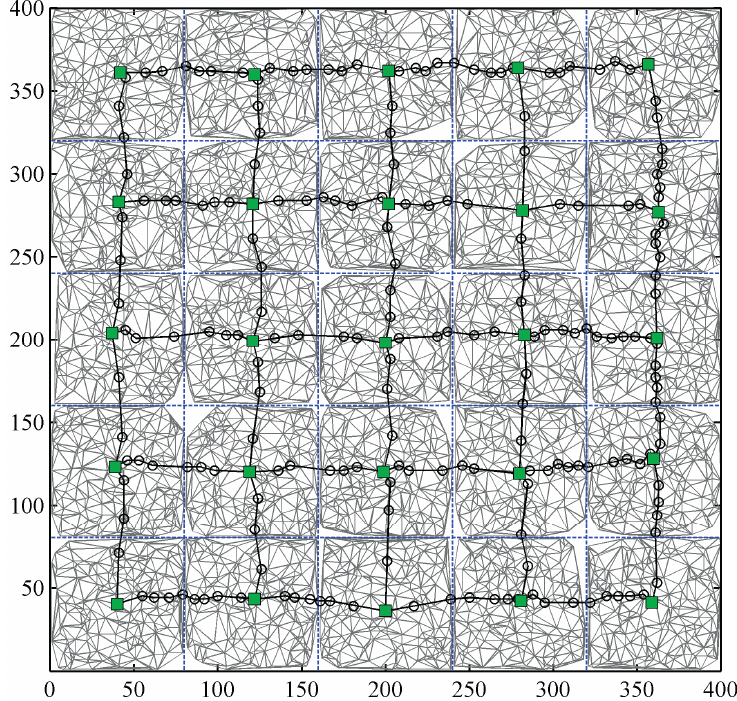
Figure 2. An example of the global control network (GCN) and the localized triangular irregular networks (LTINs) constructed with the 5000 PSs (marked by dark dots) simulated for an area with a size of 400×400 pixels. A primary control point (PCP, marked by a filled green square) is selected for each grid, and the PCPs in adjacent grids are linked by the transition PCPs (marked by black circles), thus forming the GCN (marked by black lines). All the PSs in each grid are connected to form the LTIN (marked by gray